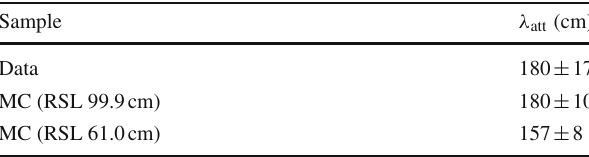
Fig. 20 Top panel: average S1 charge collected by the PEN PMTs as a function of the track-PMT distance. Two MC samples with differ- ent RSL values (61.0cm and 99.9cm) are compared to data. For each distribution, an exponential fit is plotted as a solid line. Bottom panel: data-MC ratio for the two previous MC samples Table 6 Attenuation length values obtained from the exponential fits shown in Fig.